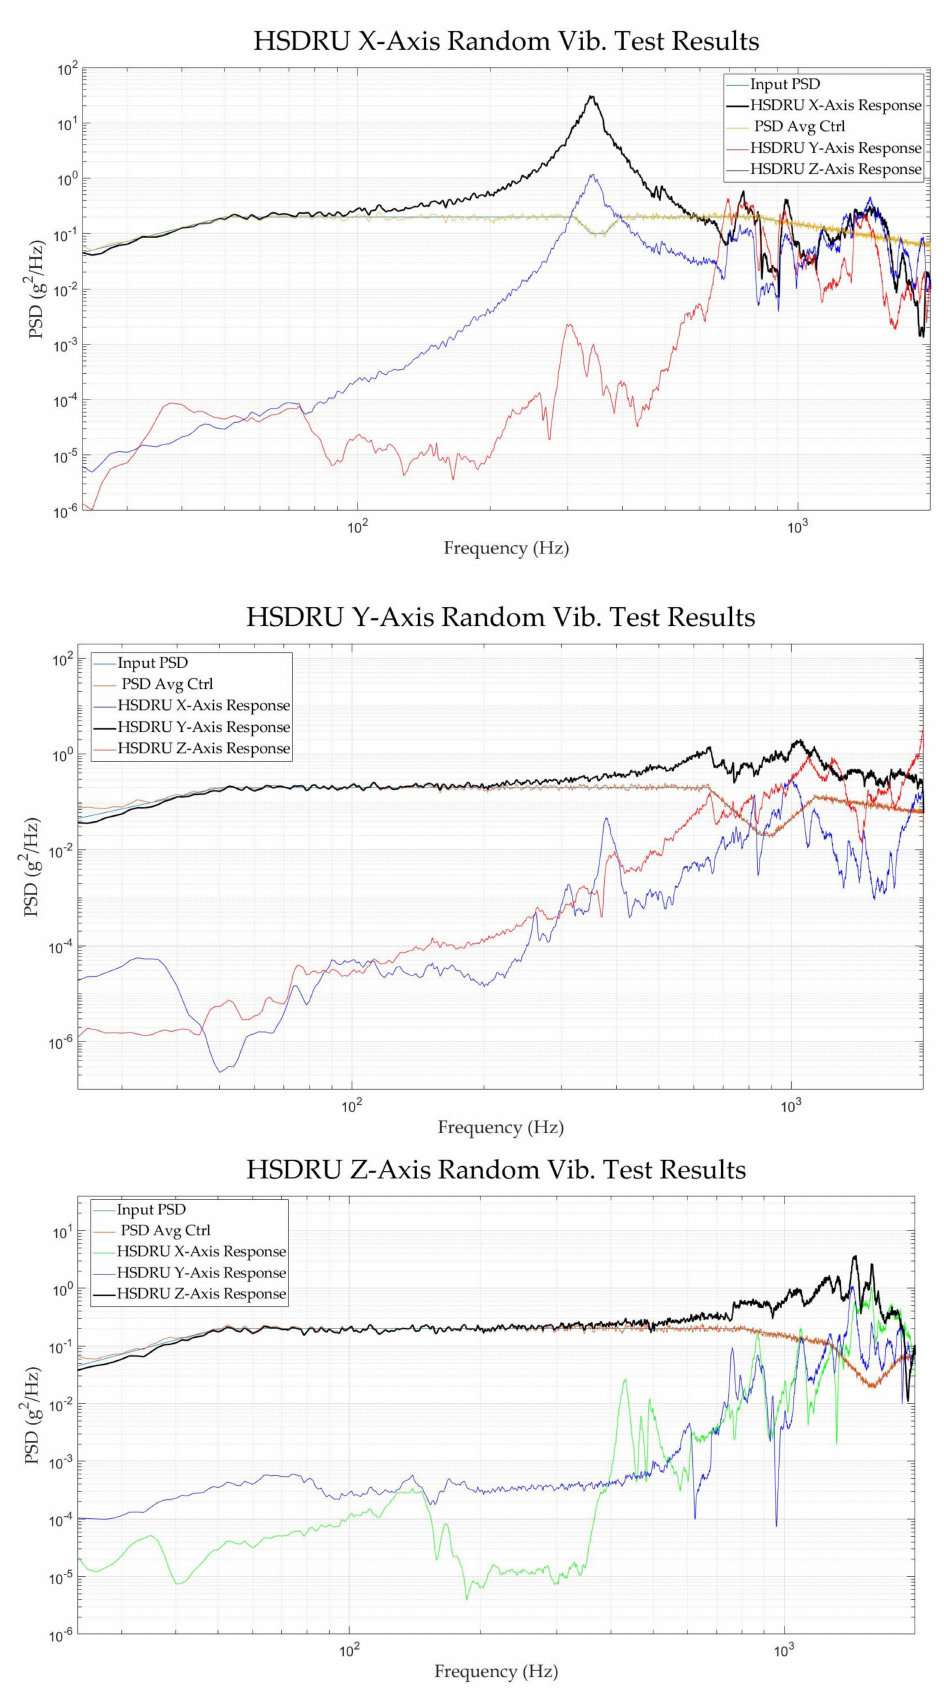
Figure 14. Random vibration test results of HSDRU about X-, Y-, and